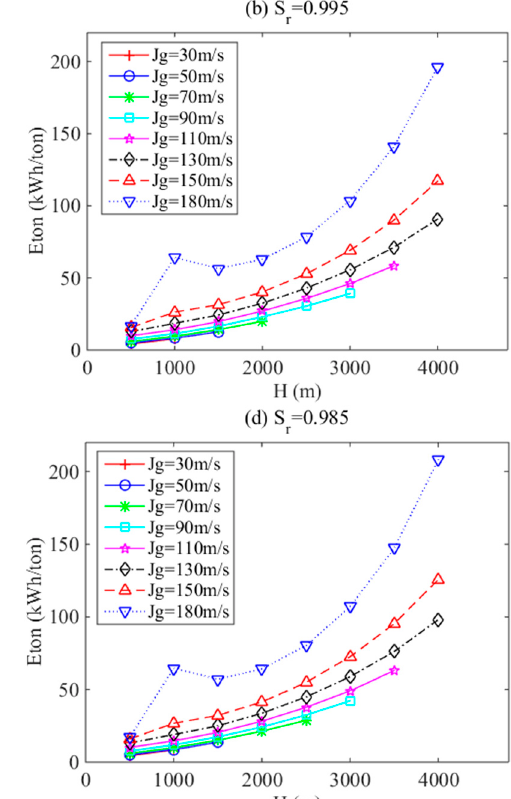
Figure 8. Figure of energy consumption per tonnage of mineral Eton influenced by submergence ratio S r at different mining depth H and gas flux rate Jg . The submergence ratio of ( a – d ) are 1.000, 0.995, 0.990, 0.985, respectively.